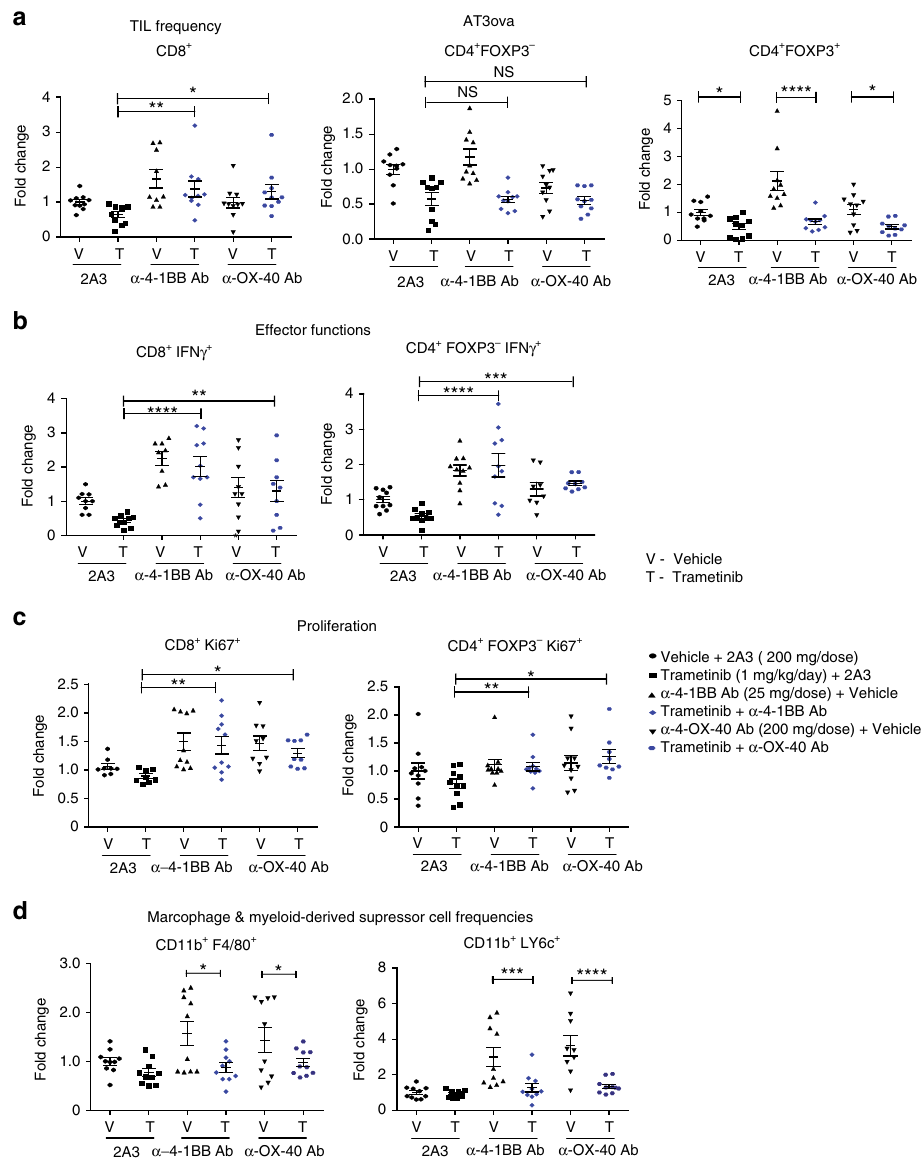
Fig. 8 Agonist immunotherapy rescues T-cell effector functions in the presence of MEK inhibition. Mice bearing established AT3ova tumors were treated with vehicle, trametinib plus isotype control antibody and either α -4-1BB or α -OX-40 antibody alone; IP injection on day 0, or combination of trametinib and agonists. Changes in TIL populations (CD8 + , CD4 + FOXP3 − , CD4 + FOXP3 + T cells, macrophage, and MDSCs) were determined ex vivo by FACS analysis 4 days post treatment. a TIL frequency as a proportion of CD45 + live cells, b IFN γ cytokine production by T cells, c proliferation of T cells measured by Ki67 expression, and d frequency of macrophage (CD11b + , F4/80 + ) and MDSC (CD11b + , Ly6c + ) subsets. Values were normalized to vehicle controls in each experiment. Data are expressed as fold change ± SEM for the number of positive cells and represents n = 5 – 10 mice per group, pooled from two independent experiments. P -values represent one-way ANOVA, post hoc Fisher ’ s LSD tests.* P < 0.05, ** P < 0.01, *** P < 0.001, **** P < AT3ova and the 4T1Ch9 cell lines. Once tumors were established (~35 – 60 mm 3 ), mice were treated with a vehicle control or trametinib and isotype control, or either α -4-1BB or α -OX-40 antibody alone, or a combination of trametinib and either isotype control, α -4-1BB, or α -OX-40 antibody. Consistent with our previous observations, some anti-tumor activity was observed with trametinib administered alone 15 . However, combined treatment of MEKi with α -4-1BB antibody resulted in signi fi cantly enhanced (two-way ANOVA; P < 0.001) inhibition of tumor growth in both the AT3ova and 4T1Ch9 models (Fig. 6a, c), and signi fi cantly prolonged (log ranked (Mantel – Cox); P < 0.0001) the survival of mice, compared to either single agent alone (Fig. 6e, g). Similarly, combined Fig. 6B) con fi rmed Ras/MAPK pathway activation in both the